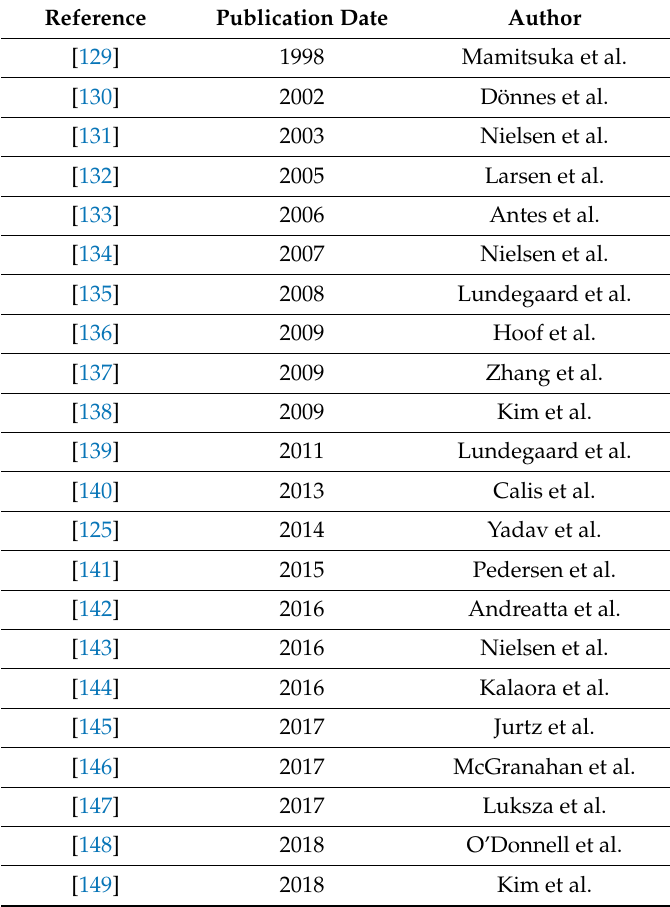
Table 4. Overview of (tumor) neoantigen prediction